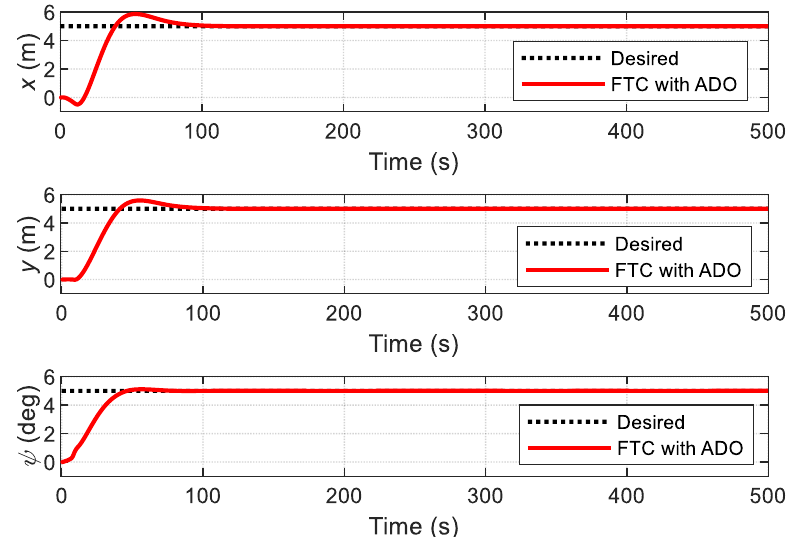
Figure 15. Position ( x , y ) and heading ψ .